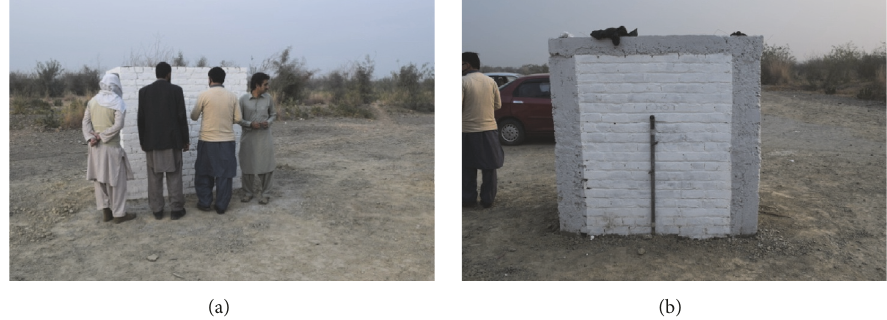
Figure 7: For scaled distance 4.5 m/kg 1/3 postblast scenario, (a) unreinforced masonry and (b) confined masonry.